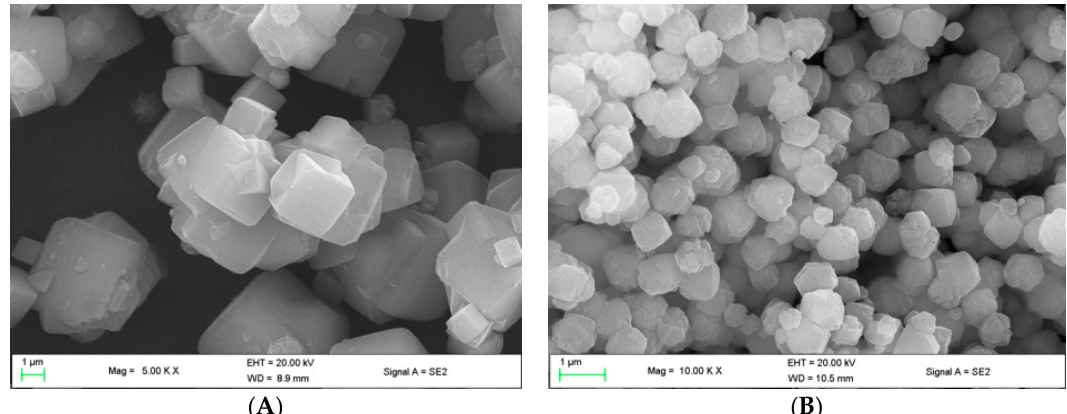
Figure 3. SEM micrographs of ( A ) Ga-BaY(Sil), ( B ) Ga-BaY(IS).